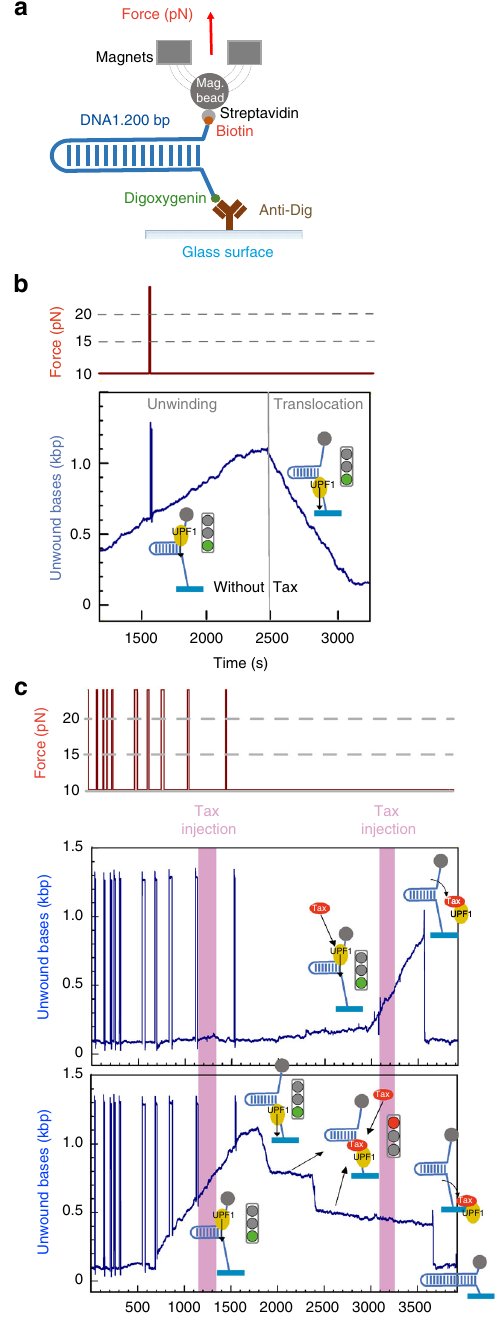
Fig. 5 Tax blocks UPF1 translocation. a Schematic representation of the DNA substrate used for the magnetic tweezers' set-up. b Experimental magnetic tweezer traces showing the activity of UPF1-HD under a saturating concentration of ATP (blue line). The trace showing the force monitoring (red line) is shown above the recorded track. The number of unwound bases is deduced from the molecular extension Z (t) obtained at F = 10 piconewton (pN). From 1000 to 2500 s, the helicase unwound the ~1200 bp DNA hairpin. From 2500 to 3200 s, the DNA hairpin refolded while the UPF1-HD translocated on the ss-DNA. c The upper and lower panels show two types of enzymatic activity detected for UPF1-HD in the presence of Tax. On the upper panel, UPF1-HD is unwinding the DNA hairpin between 3000 and 3625 s before dissociation induced by Tax binding. On the lower panel, UPF1-HD is unwinding the whole DNA hairpin between 500 and 1750 s and translocating between 1750 and 1920 s on the ss-DNA. Tax blocks UPF1-HD translocation twice between 1920 and 2370 s and 2414 and 3660 s. A sliding event and the fi nal dissociation of UPF1-HD can be observed at 2372 and 3660 s,